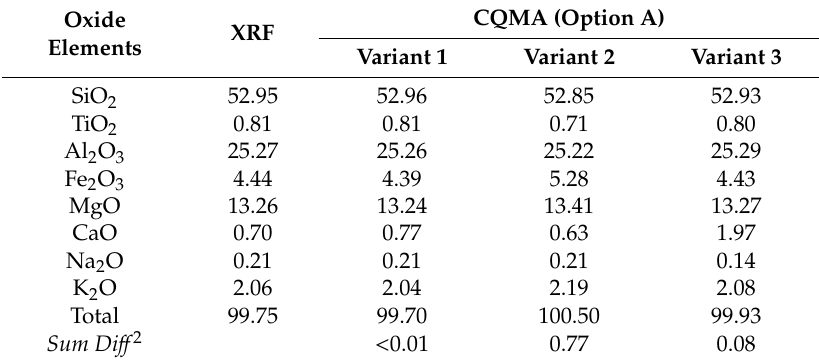
Table 5. Recalculated mineral analyses (Table 4) on chemical analyses (wt%) by CQMA (option A) method and their comparison with bulk chemical analysis